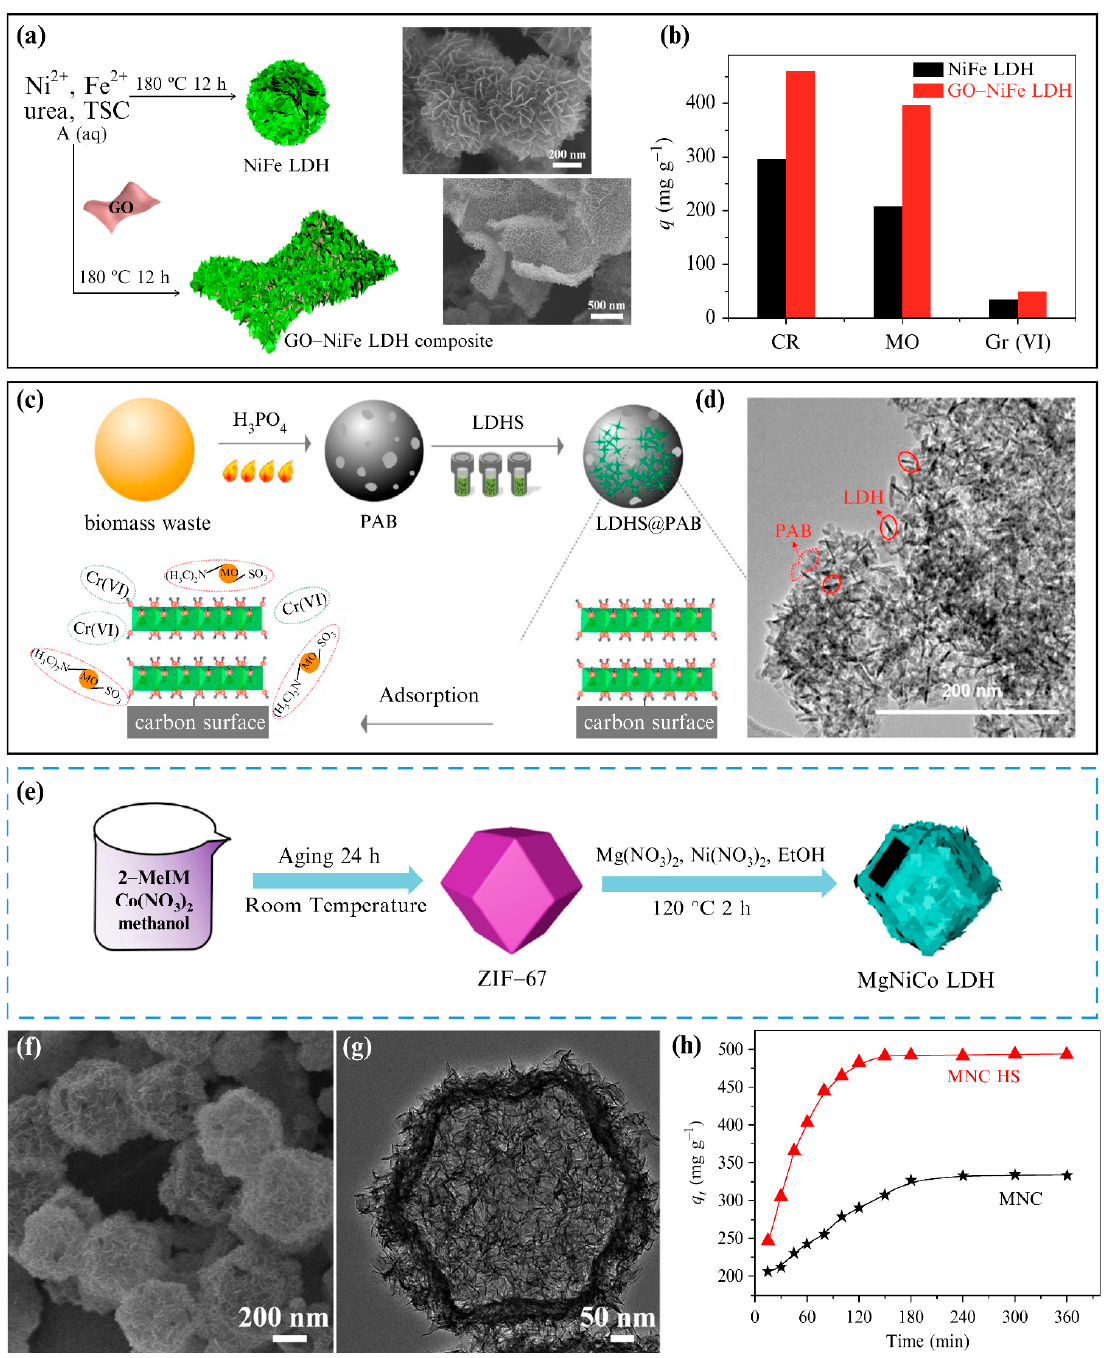
Figure 9. ( a ) Schematic illustration of the synthesis of graphene oxide (GO) − Ni − Fe LDH. ( b ) Absorption capacities of the Ni − Fe LDH and GO − NiFe LDH composite. Reproduced with permission from [65]. ( c ) Synthesis procedure for the LDH@biomass-derived porous carbon (PAB) composite. ( d ) TEM image of the LDH@PAB composite. Reproduced with permission from [66]. ( e ) Synthesis process of the MgNiCo LDH hollow structure (MNC HS), and its ( f ) field emission scanning electron microscopy (FESEM) and ( g ) TEM images. ( h ) Kinetic curves for Congo red (CR) adsorption on the MNC and MNC HS samples (CR concentration = 50 mg L − 1 , adsorbent dose = 0.1 g L − 1 , T = 30 °C). Reproduced with permission from [67].